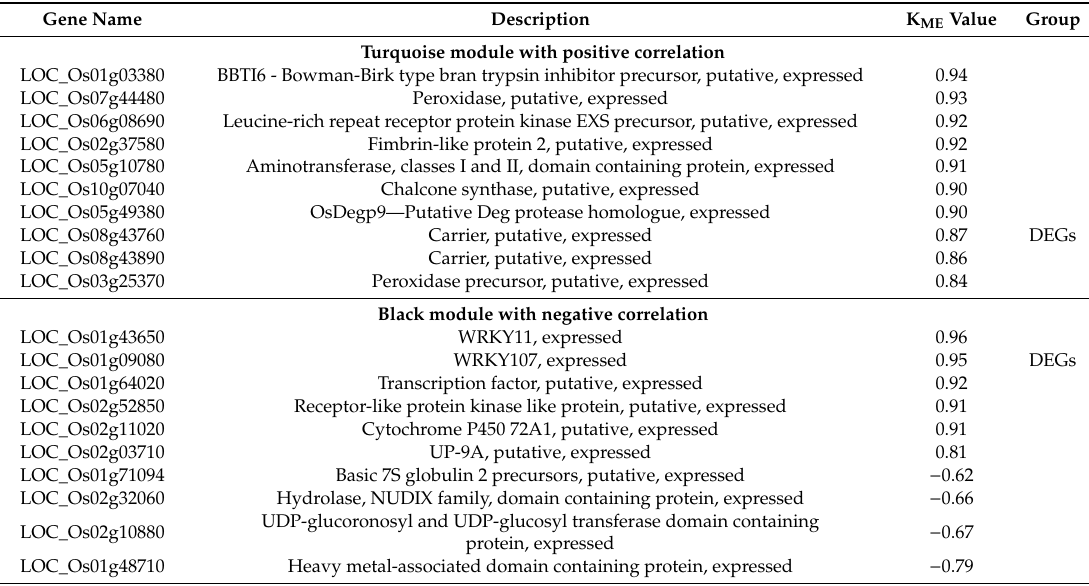
Table 2. Candidate hub genes associated with the scale of average